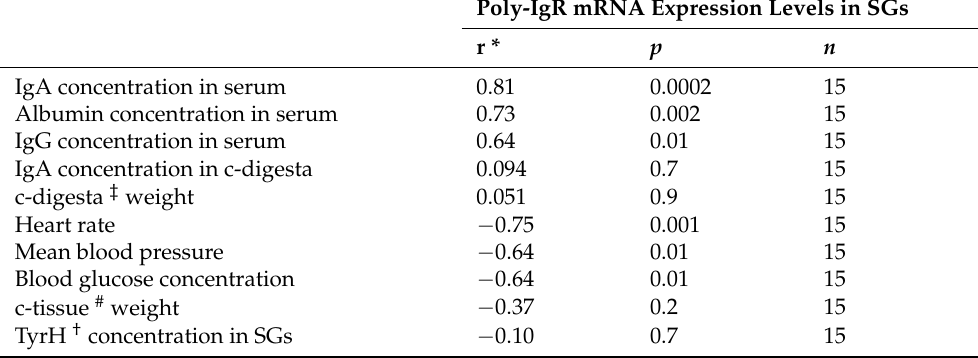
Table 2. Correlation between polymeric immunoglobulin receptor (poly-IgR) expression levels in the submandibular gland (SG) and different